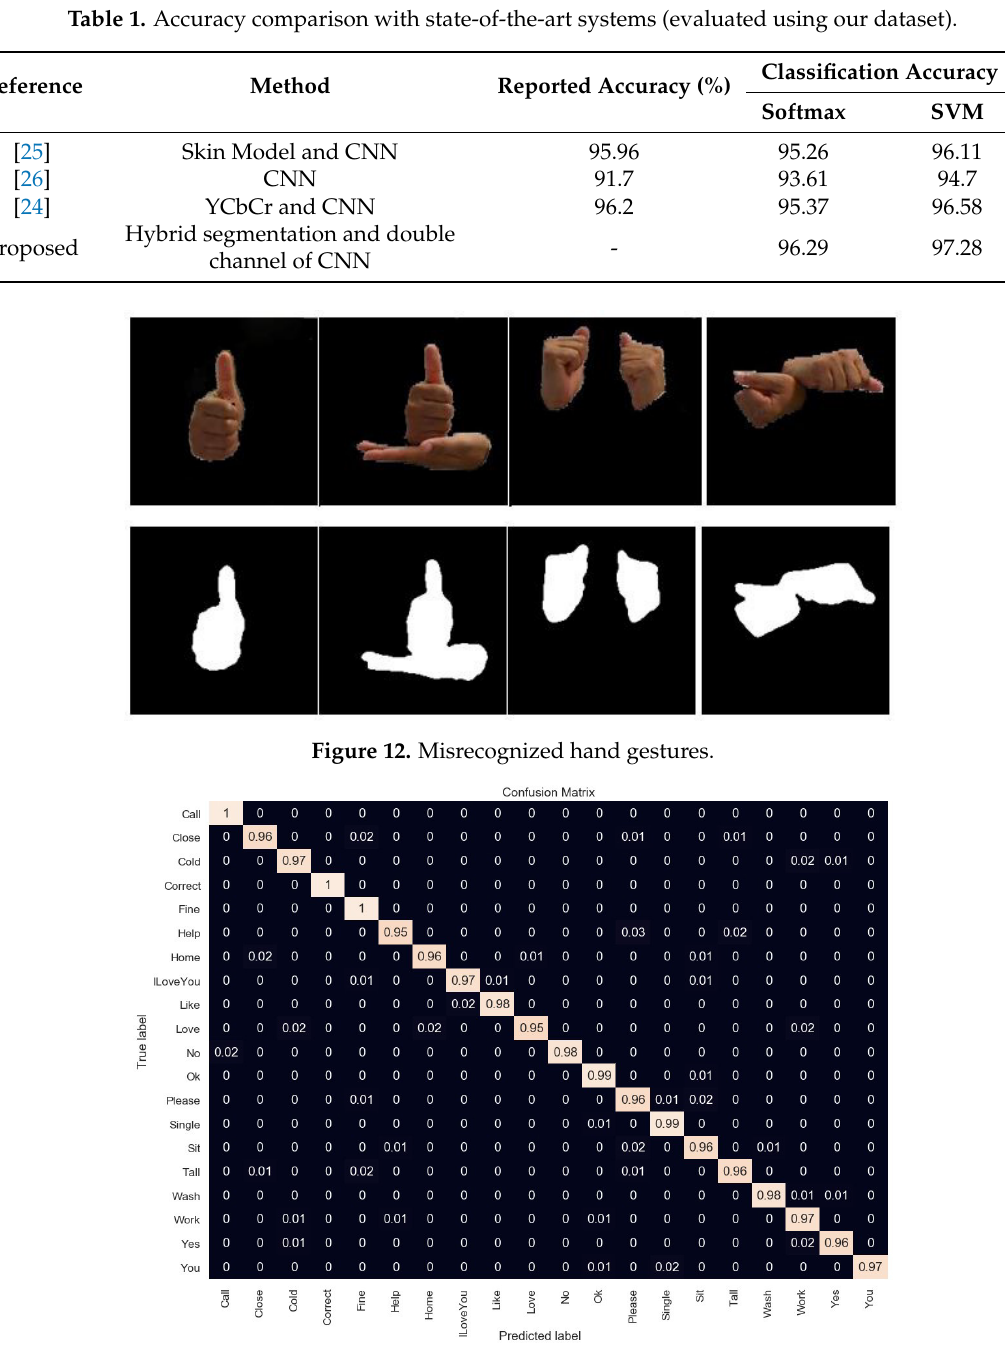
Figure 13. Confusion matrix of recognition